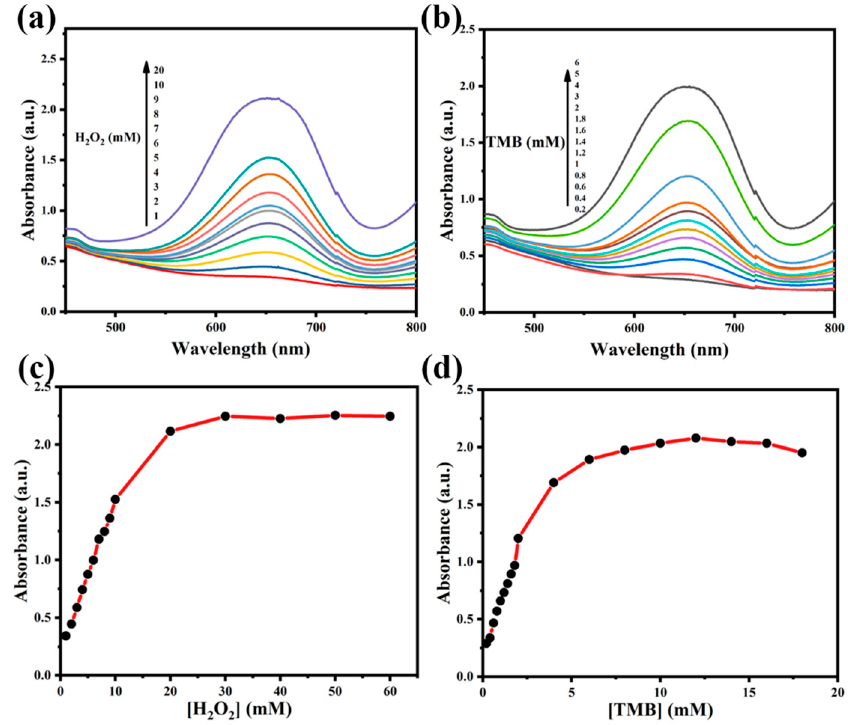
Figure 4. ( a , b ) UV-vis absorption spectra and ( c , d ) absorbance of assembled Fe 3 O 4 @PEI@Ag structure (200 µ g · mL − 1 ) incubated at different concentrations of ( a , c ) H 2 O 2 and ( b , d ) TMB for 10